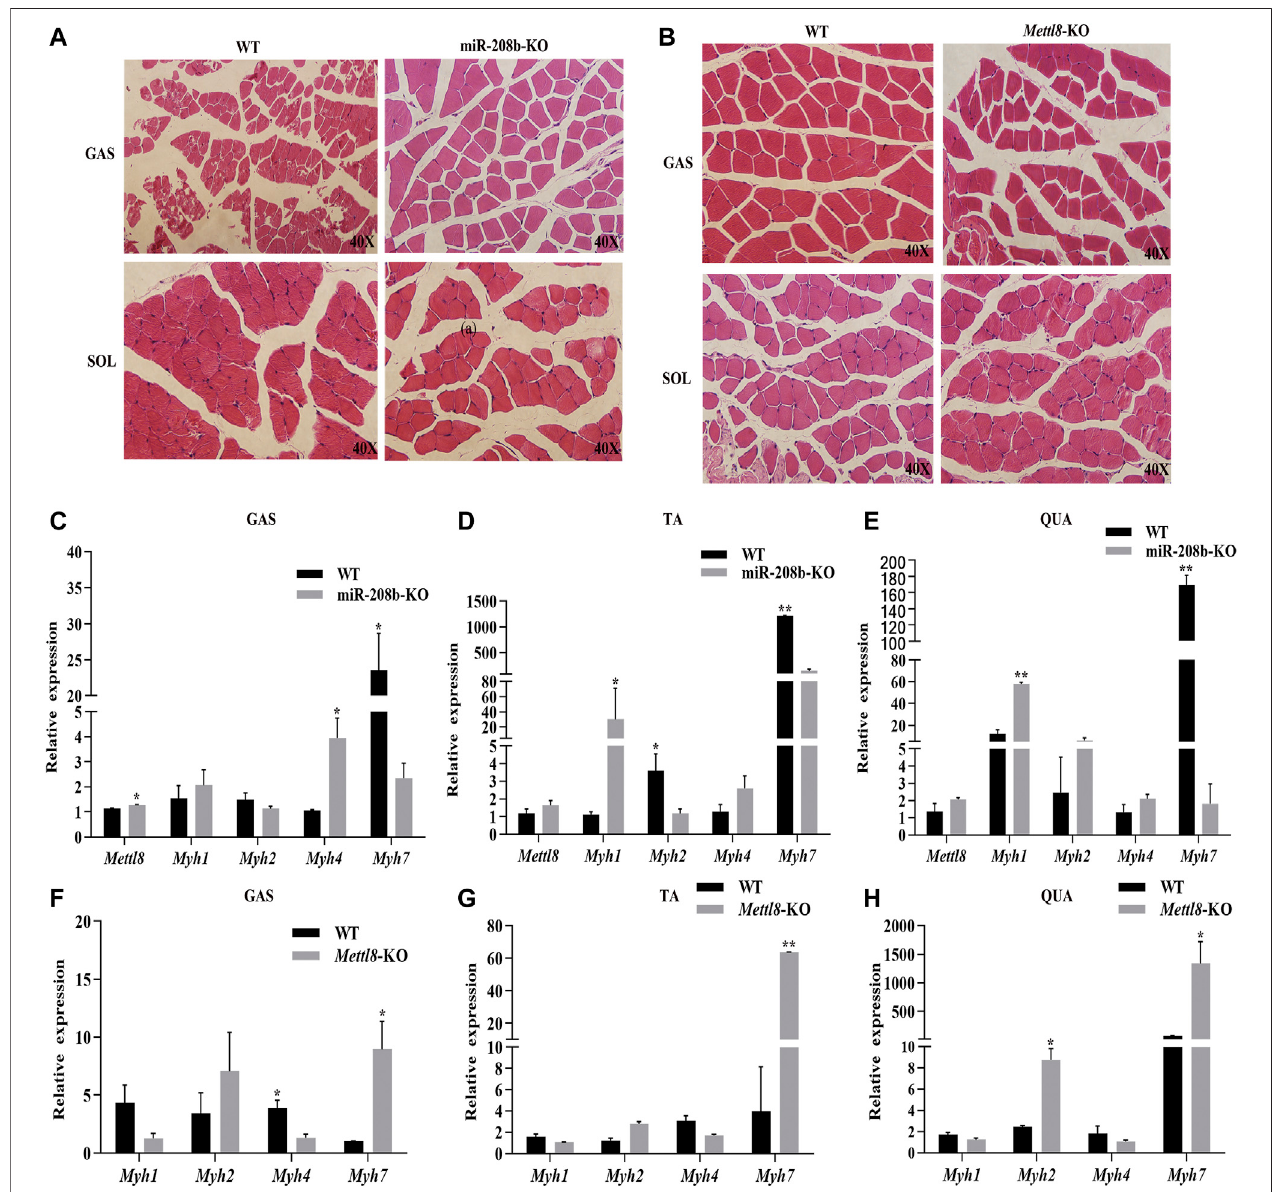
FIGURE 6 | Transformation of different skeletal muscle fi ber types in miR-208b and Mettl8 knockout mice. (A) HE staining (40×) of skeletal muscle from miR-208b knockoutmiceandwild-typemice. (B) HEstaining(40×)ofskeletalmusclefromMettl8knockoutmiceandwild-typemice. (C – E) :ExpressionlevelsofMettl8andMyHCin GAS (C) ,TA (D) ,andQUA (E) ofmiR-208bknockoutmiceandwild-typemice,respectively. (F – H) :ExpressionlevelsofMettl8andMyHCinGAS (F) TA (G) andQUA (H) of Mettl8 knockout mice and wild-type mice, respectively. WT: wild-type mice; miR-208b-KO: miR-208b gene knockout mice; Mettl8-KO: Mettl8 gene knockout mice; GAS: gastrocnemius muscle; SOL: soleus muscle; QUA: quadriceps muscle. Statistical comparisons are performed using multiple t -tests. * p < 0.05; ** p <